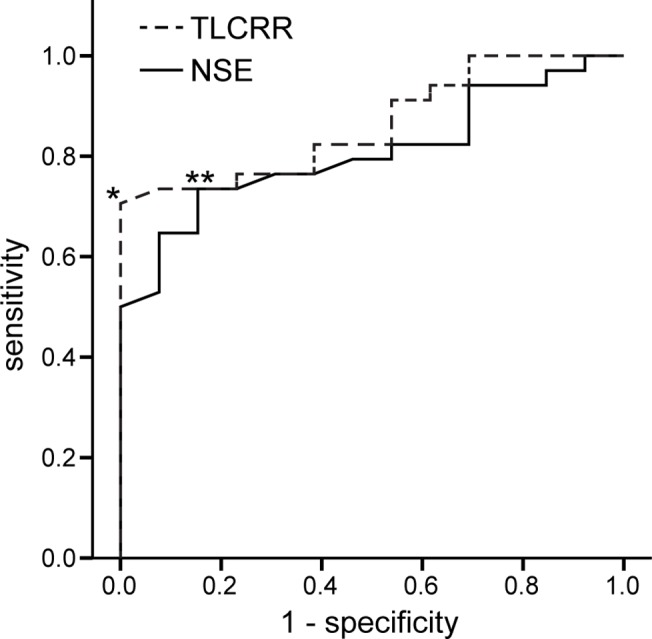
ROC of TLCRR and serum NSE for prediction of unfavorable histopathology.Receiver-operating-characteristic (ROC) is given for TLCRR (dashed line) and serum NSE (continuous line). AUC-ROC was 0.86 for TLCRR. Optimal cut-off determined by the Youden index was 2.0 (*), resulting in a sensitivity of 68% and a specificity of 100%. AUC-ROC was 0.81 for serum NSE. Optimal cut-off was 25.8 ng/ml (**) with a sensitivity of 74% and a specificity of 85%. AUC-ROC = area under the receiver-operating-characteristic, TLCRR = tumor-to-liver count-rate ratio, NSE = neuron-specific enolase.